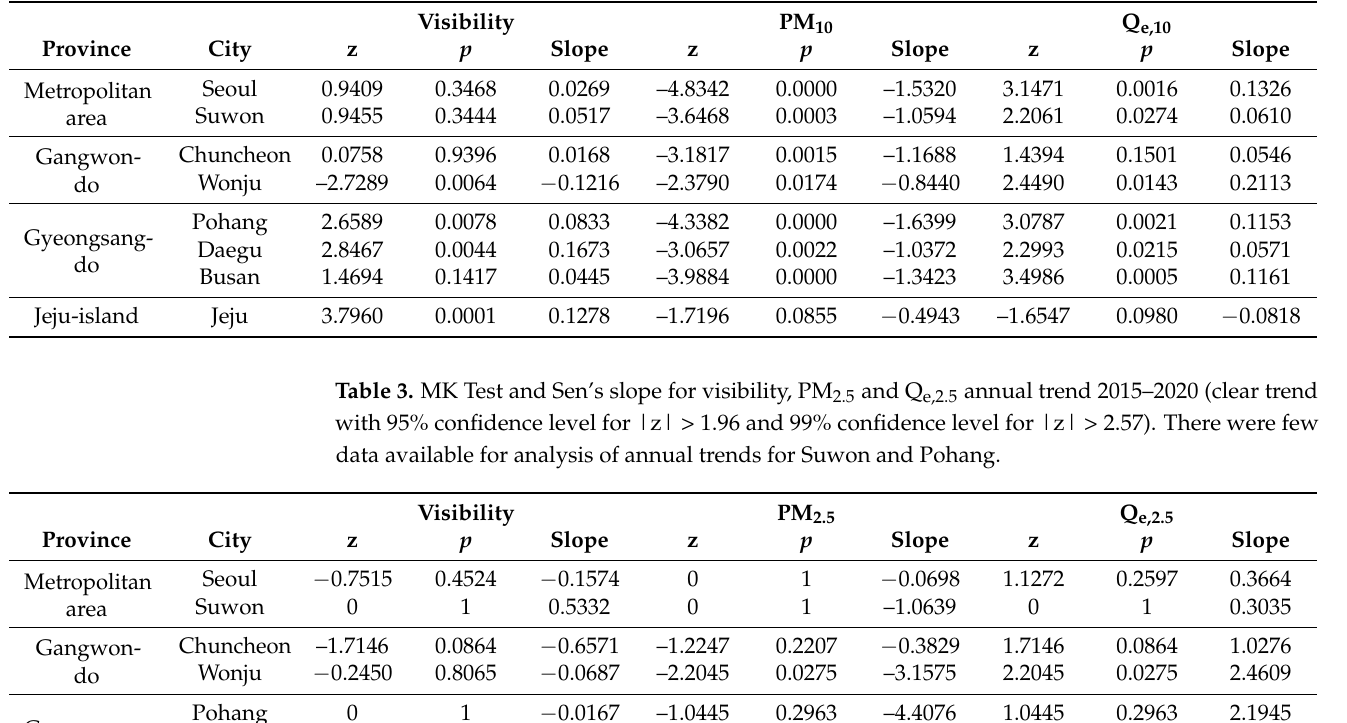
Table 2. MK test and Sen’s slope of Visibility, PM 10 and Q e,10 annual trends 2001–2020 (Clear trend with 95% CL for |z| > 1.96 and 99% CL for |z| > 2.57).